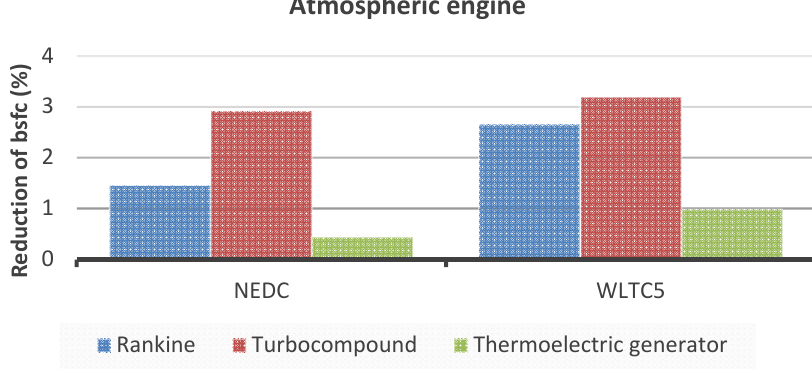
Figure 8. Reduction of fuel consumption for an atmospheric